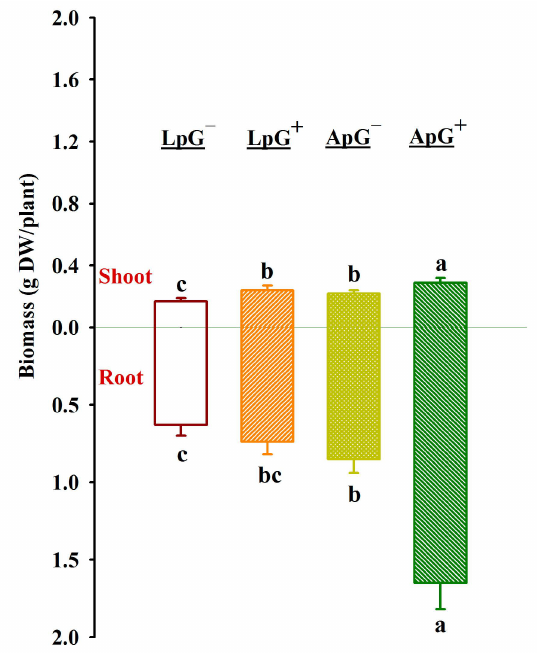
Figure 1. Changes in shoot and root biomass of Polygonum cuspidatum inoculated with Glomus mosseae in low and approximate P levels. Different letters in the bars indicate significant differences between treatments at the 0.05 level. Abbreviations: LpG − , plants inoculated without G . mosseae in low P levels; LpG + , plants inoculated with G . mosseae in low P levels; ApG − , plants inoculated without G . mosseae in appropriate P levels; ApG + , plants inoculated with G . mosseae in appropriate P